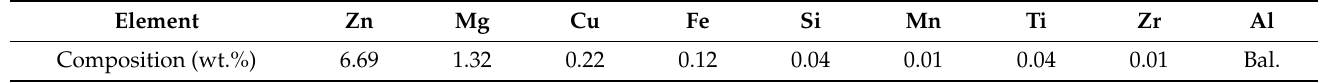
Table 1. The chemical composition (wt.%) of the studied alloy. Element Zn Mg Cu Fe Si Mn Ti Zr Al Composition (wt.%) 6.69 1.32 0.22 0.12 0.04 0.01 0.04 0.01